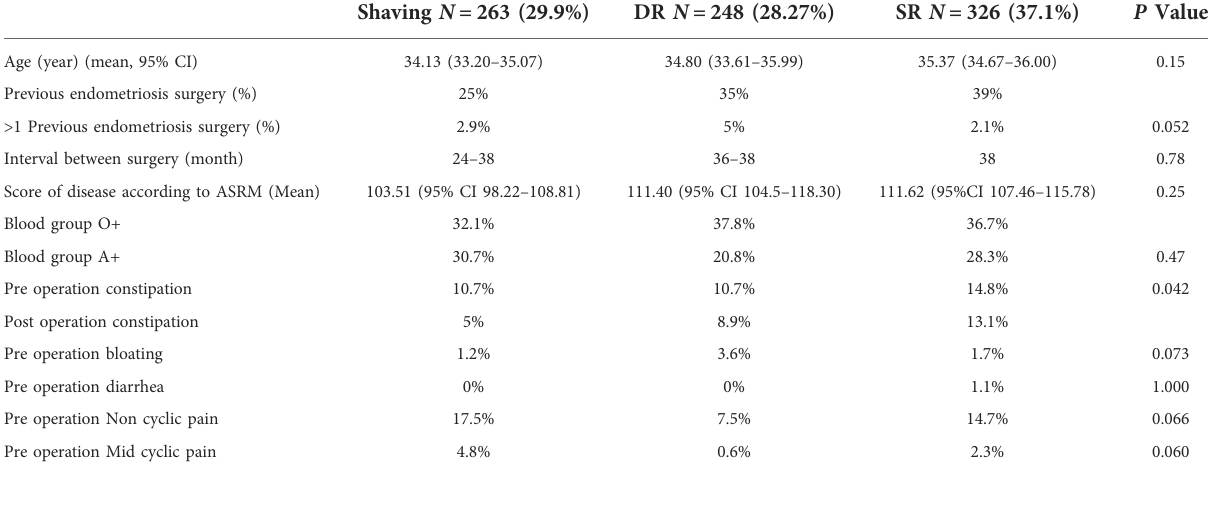
TABLE 1 Demographic data of all three groups of